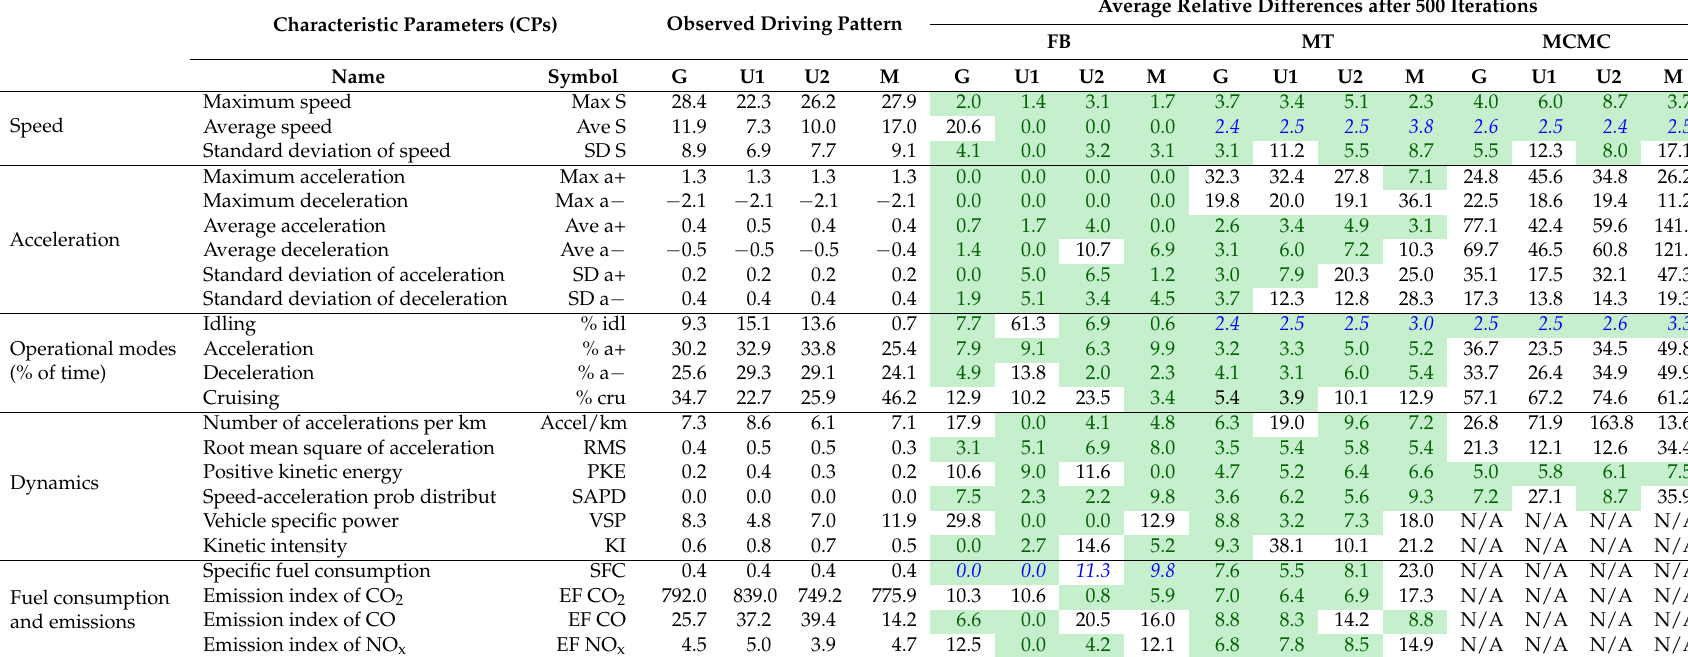
Table 4. CPs that describe the driving patterns, fuel consumption and emission of pollutants, observed in regions G (General), U1 (Urban 1), U2 (Urban 2) and M (Mountain). Average relative differences (in percentage) observed between CPs of driving pattern and driving cycle, after 500 iterations. Boxes highlighted in green correspond to CPs with average relative differences below 10%. The numbers highlighted in italic and blue, indicates that the corresponding CP was used by the specified method as the assessment criteria for the construction of the DC. N/A: Not